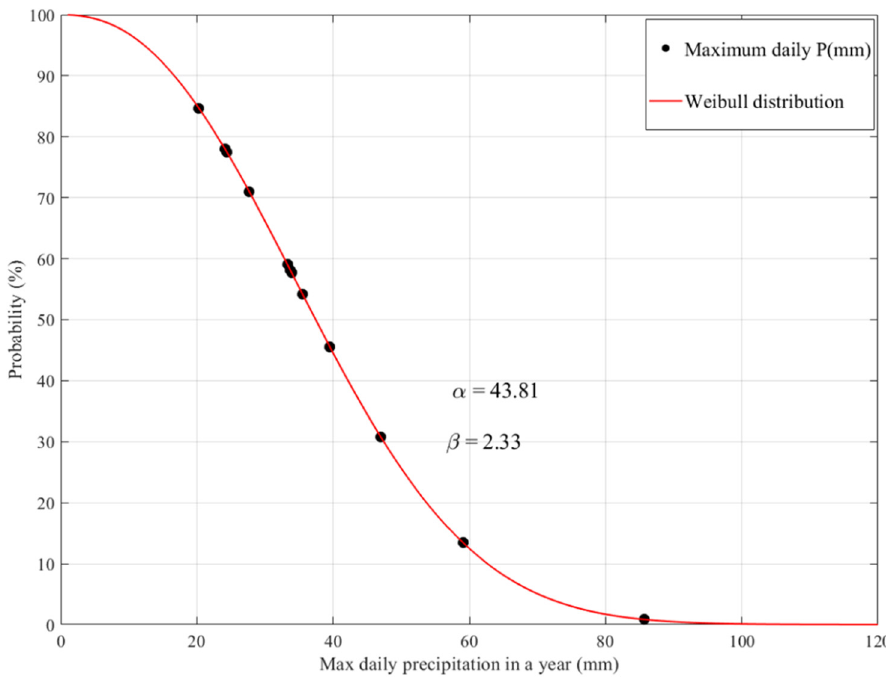
Figure 11. Two-parameter Weibull distribution (red line) for maximum daily rainfall.